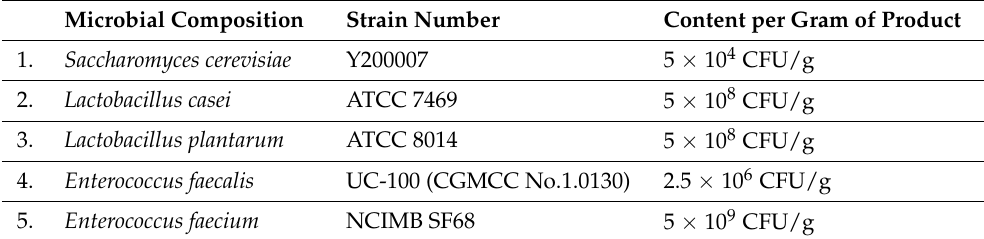
Table 3. Composition of EM Bokashi ®